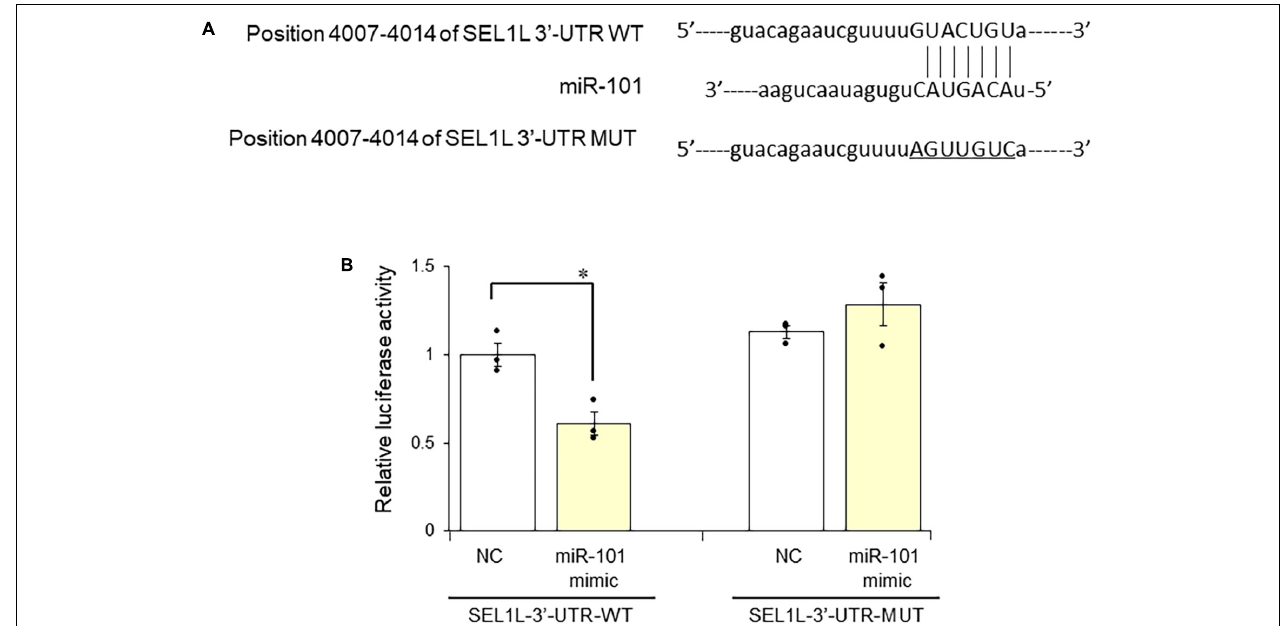
FIGURE 2 | MiR-101 regulates the suppressor enhancer Lin12 1-like (SEL1L) 3 (cid:48) -untranslated region (3 (cid:48) -UTR). (A) Schematic diagram of the miR-101 target site in the 3 (cid:48) -UTR of SEL1L mRNA. (B) Luciferase reporter assay was performed in SH-SY5Y cells cotransfected with vectors carrying the wild-type (pmirGLO-SEL1L-3 (cid:48) -UTR-WT) or mutant (pmirGLO-SEL1L-3 (cid:48) -UTR-MUT) SEL1L 3 (cid:48) -UTR construct together with the miR-101 mimic or negative control (NC) for 24 h. Data are presented as means ± standard error of the mean of the relative ratio of firefly luciferase activity to Renilla luciferase activity in three independent experiments performed in triplicate. ∗ p < 0.05, Student’s t